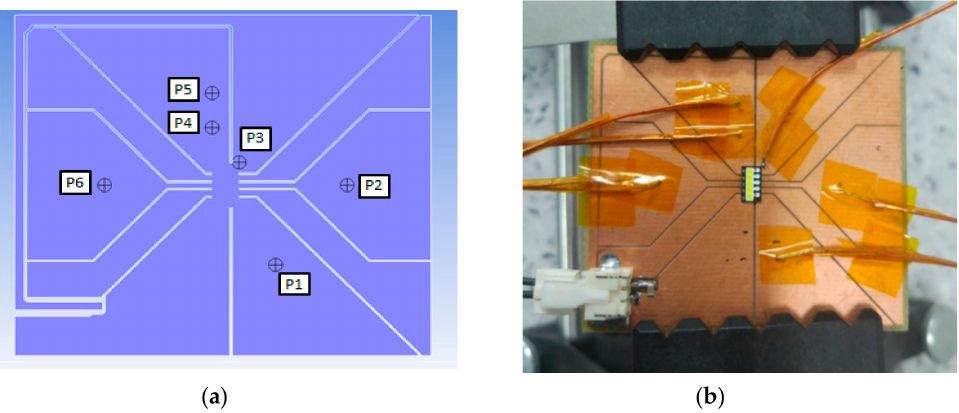
Figure3. Temperaturemeasurementpointsindi ff erentlocations: ( a )Numericalmodel; ( b )Experimental study.